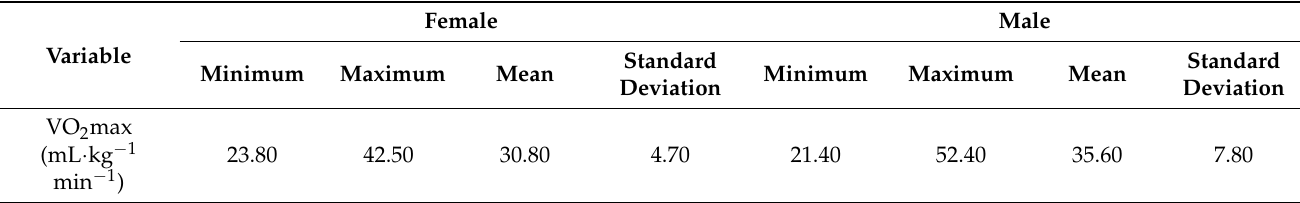
Table 2. Descriptive statistics for the subjects’ maximal oxygen